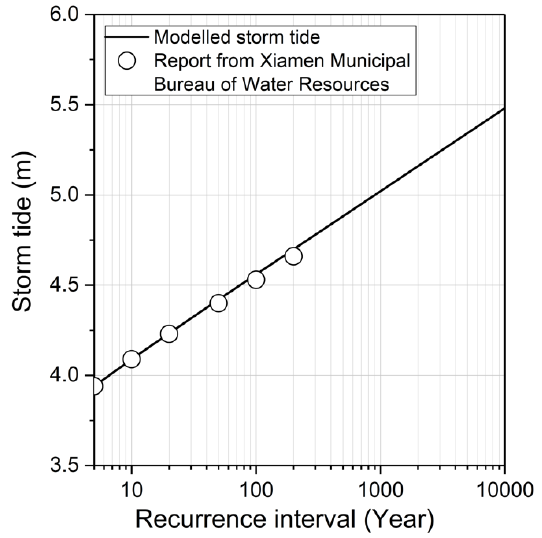
Figure 6. Modelled storm tide at different return periods